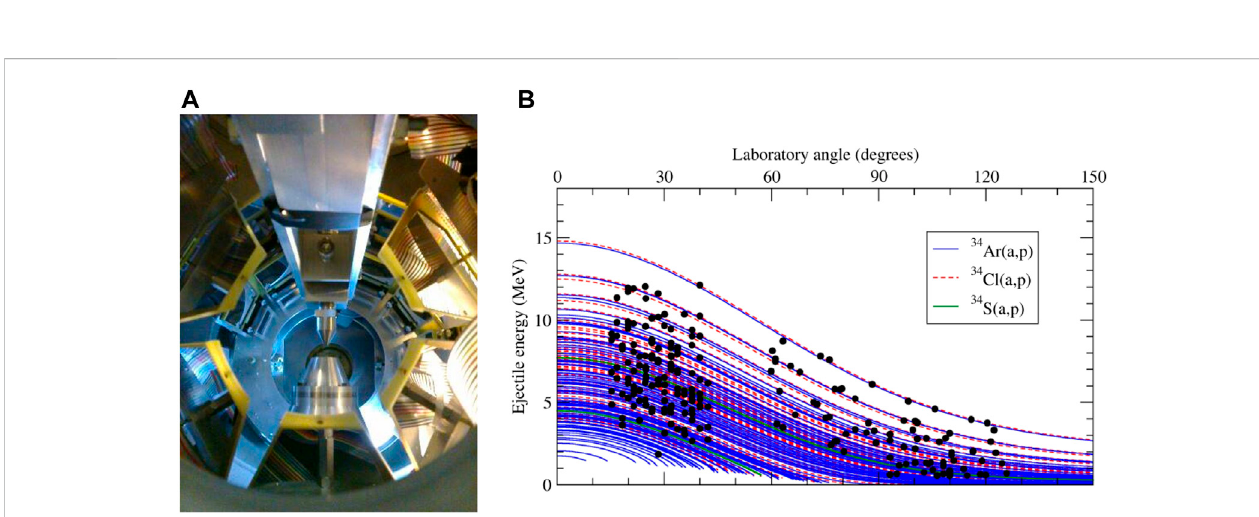
FIGURE 7 (A) He gas is injected from the top and captured for recirculation by a receiver at the bottom of JENSA. The beam is tuned down the center of the apparatus.Theinteractionpointissurroundedbyarraysofsilicon-stripdetectors. (B) Protonsfrom( α , p )reactionsareplottedalongwithcalculatedkinematic lines for reactions on the beam